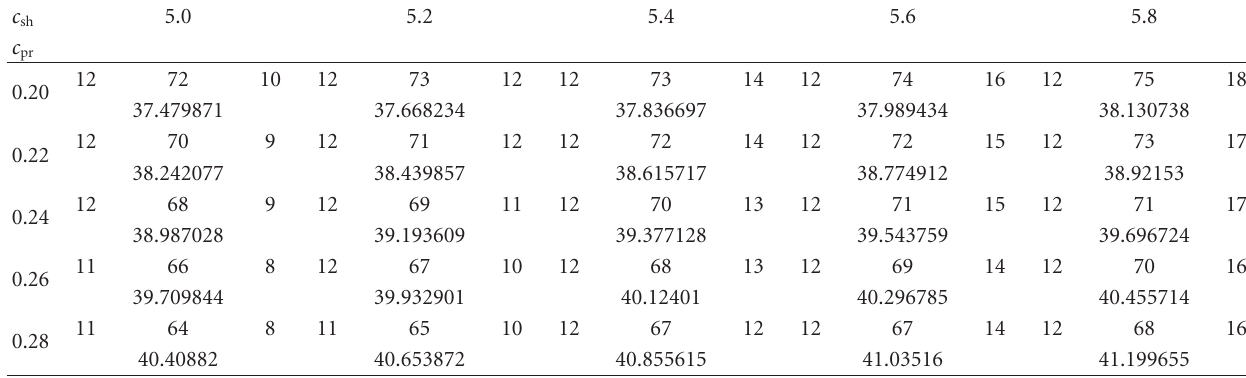
Table 19: E ff ect of c sh and c pr on the optimal cost rate ( c s = 15, c h = 0 . 3, c p = 3).